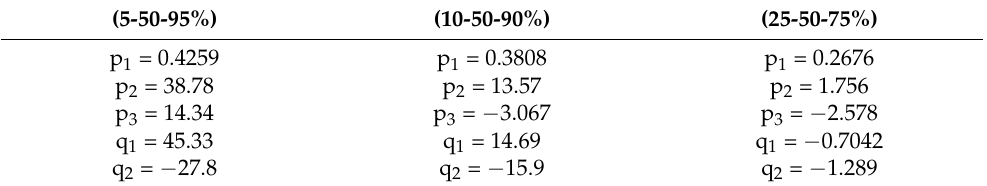
Table 3. Parameters {p i , q i } of the rational function f 1 ( ∆ ) for the different sets of symmetrical points.